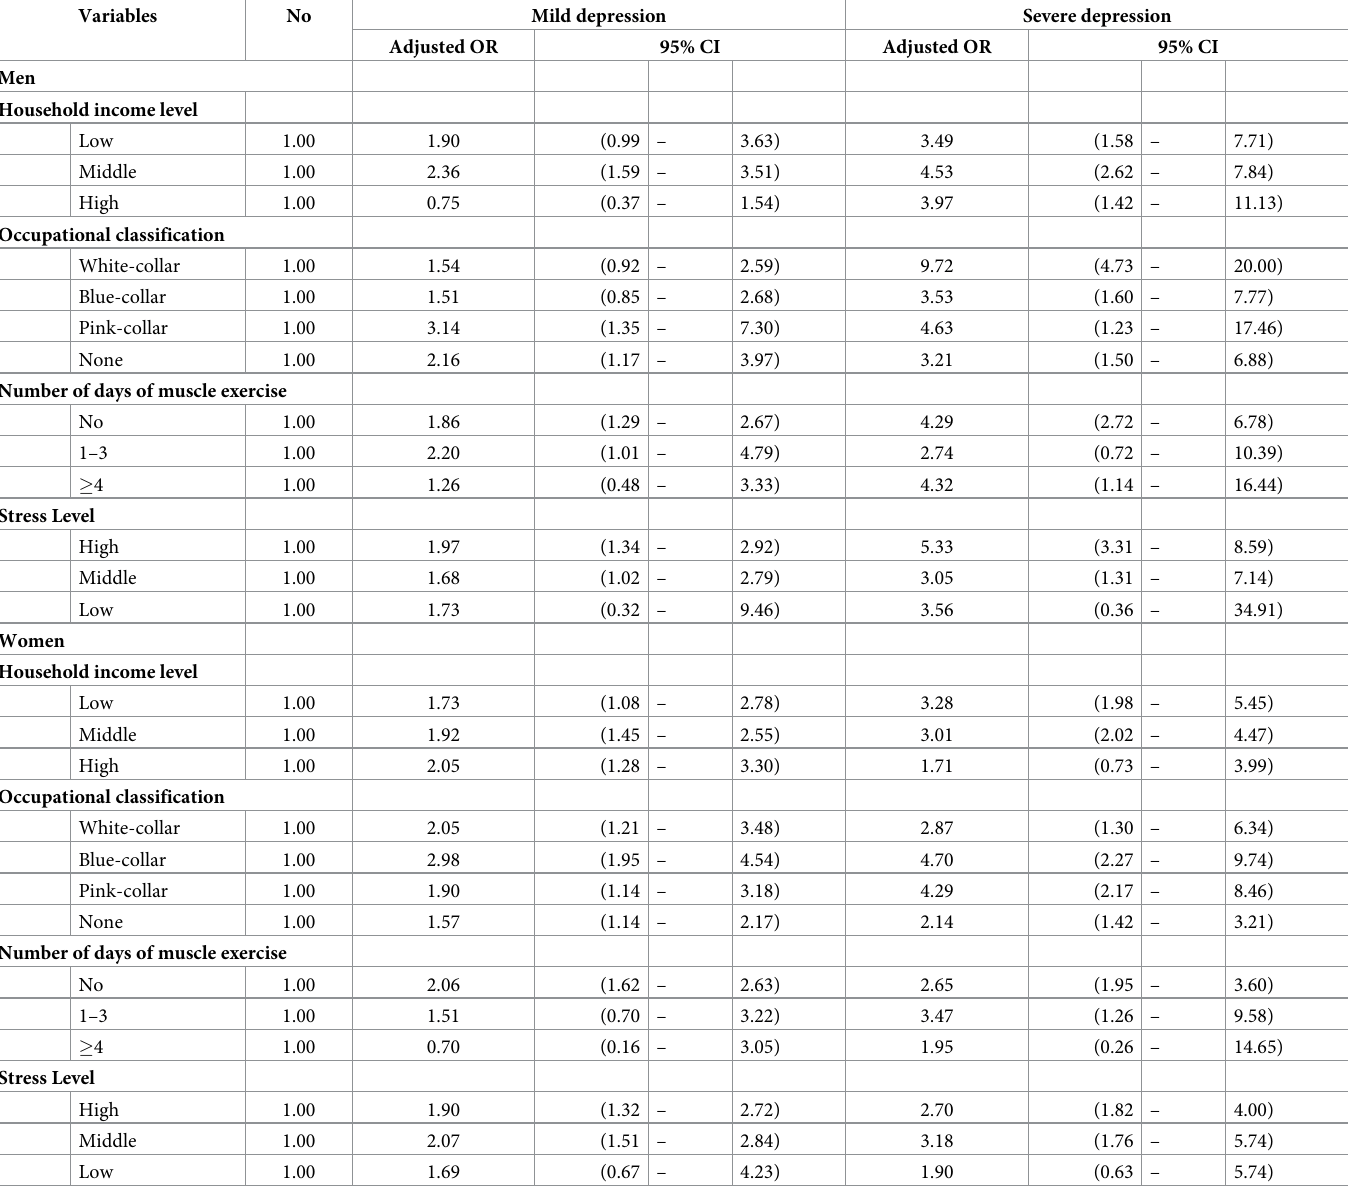
Table 3. Subgroup analysis associations between depression and unmet healthcare needs stratified by